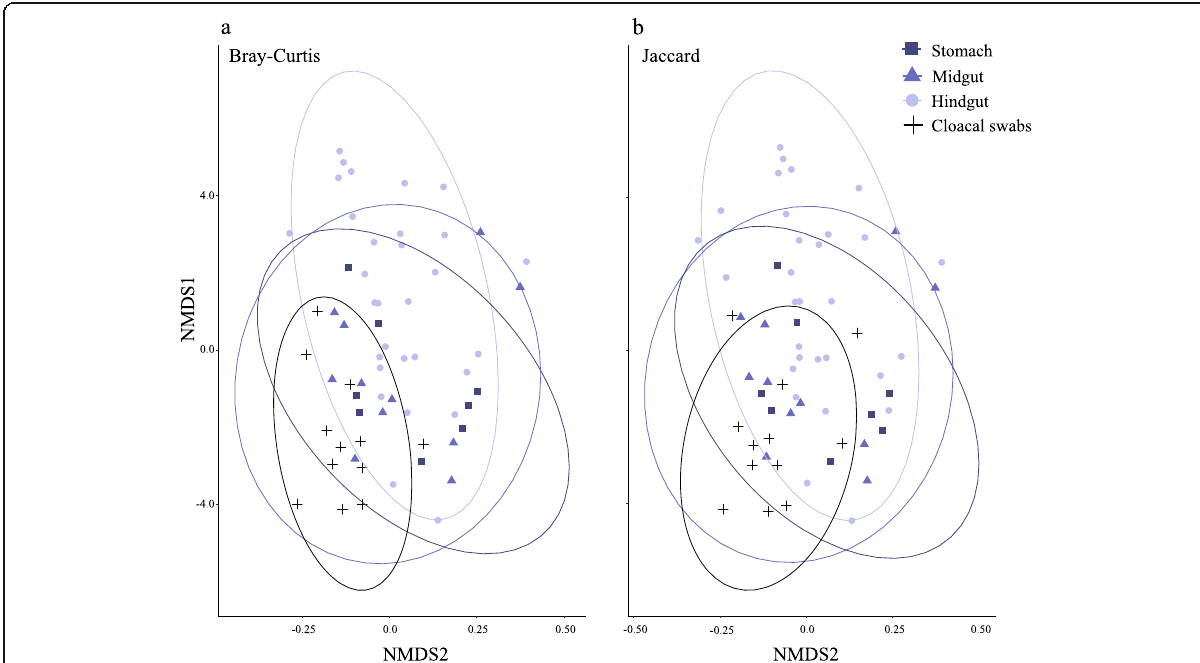
Fig. 3 NMDS plots representing gut microbial community similarities based on a Bray-Curtis and b Jaccard distances of the stomach, the midgut (beginning of small intestine, middle of small intestine, ileum), the hindgut (the large intestine and the cloaca) and cloacal swabs. Gut sections were merged into major gut regions to increase clarity of the ordination. Ellipses represent 95% confidence